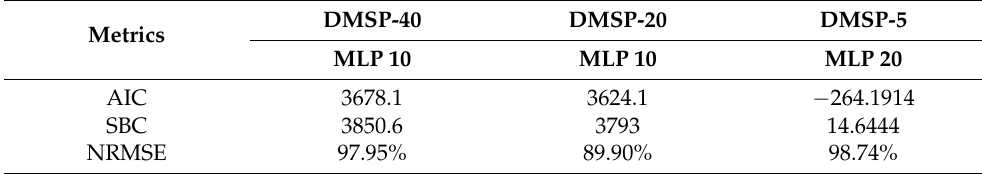
Table 17. Summary of the best results for each type of DMSP fluidic